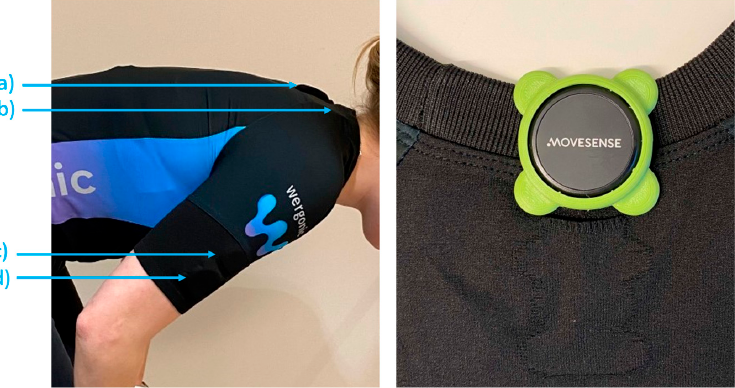
Figure 1. To the left: the two sensor setups showing ( a ) the trunk sensor in the shirt; ( b ) the trunk sensor on the skin; ( c ) the right upper arm sensor on the skin; and ( d ) the right upper arm sensor in the shirt. To the right: the Wergonic T-shirt pocket and the matching sensor